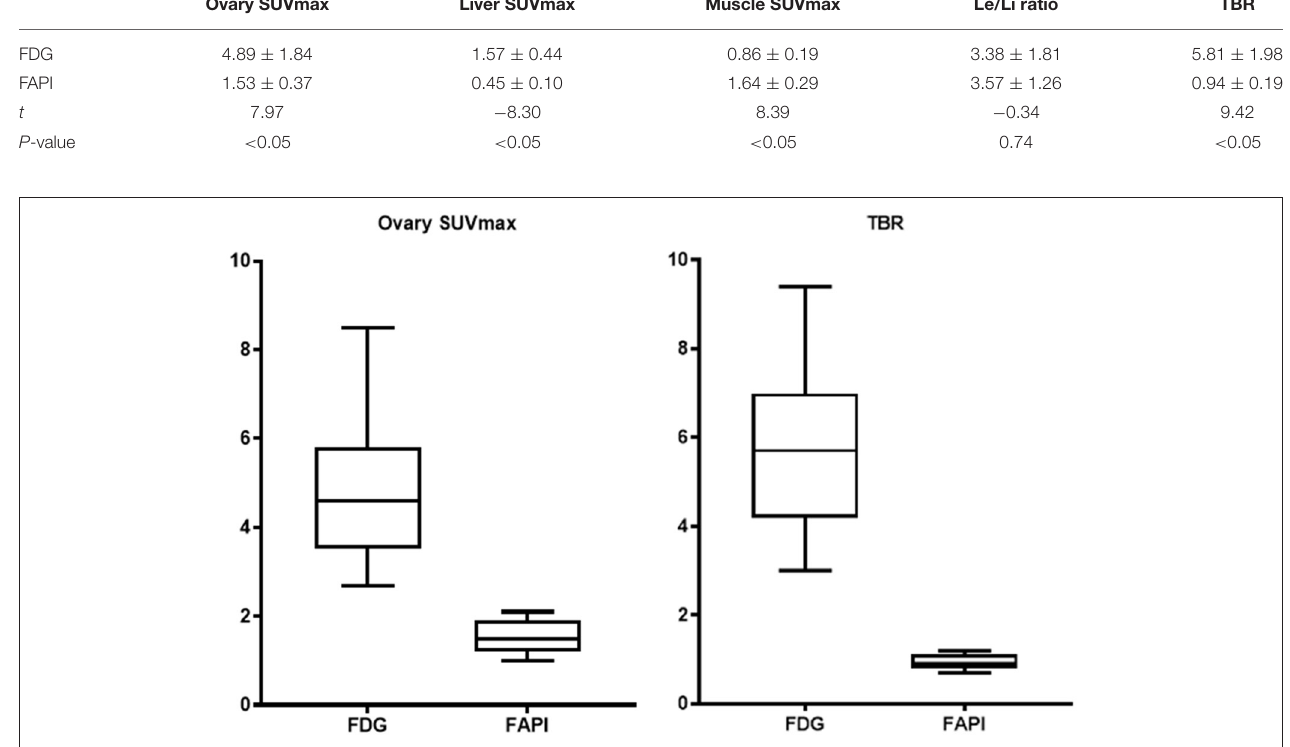
FIGURE 3 | Comparison of FDG and FAPI